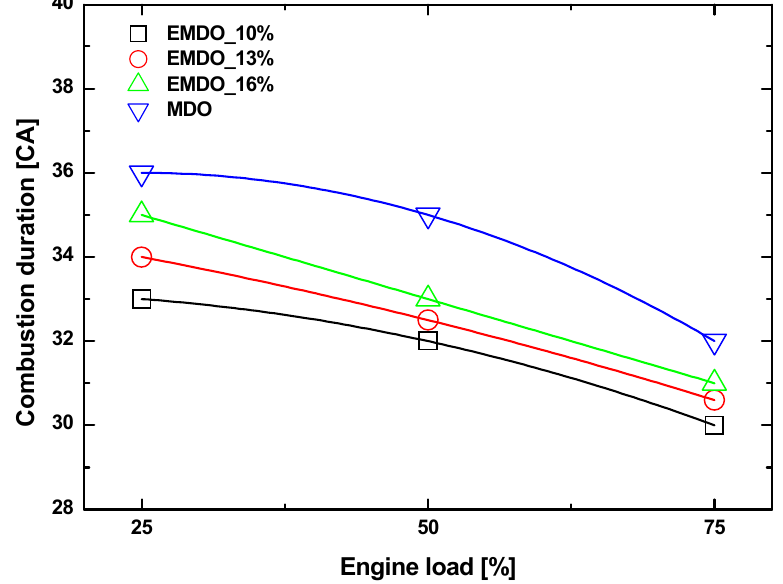
Figure 6. Characteristics of combustion duration according to engine loads.